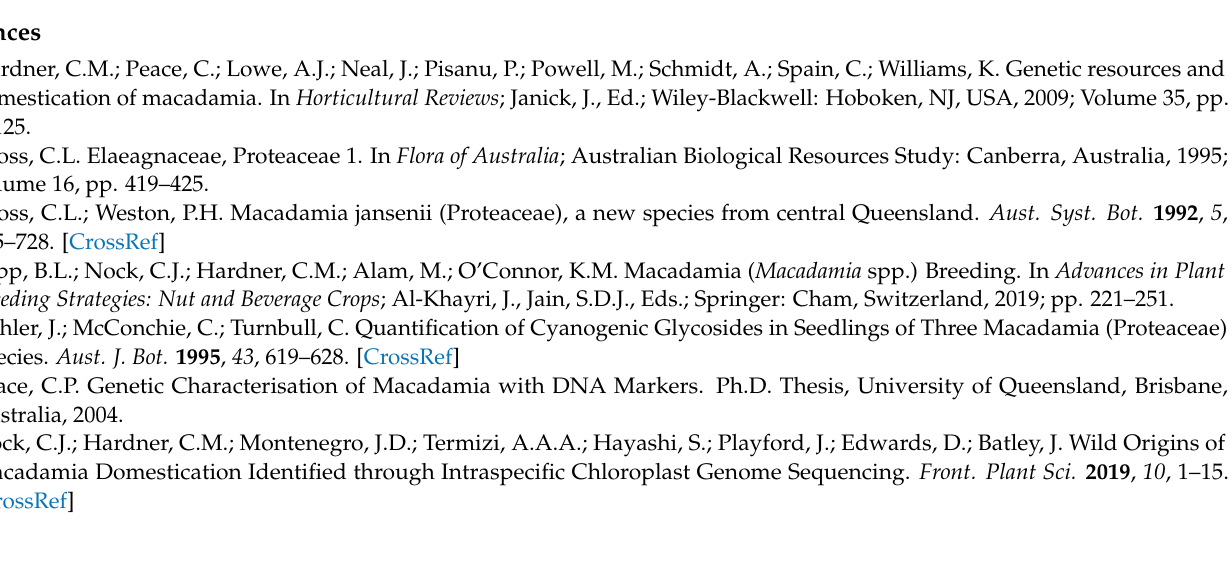
component (PC) coefficients of all traits. Figure S1: Correlation between predicted values of the traits and latitude in M. integrifolia . Figure S2: Correlation between predicted values of the traits and latitude in M. tetraphylla